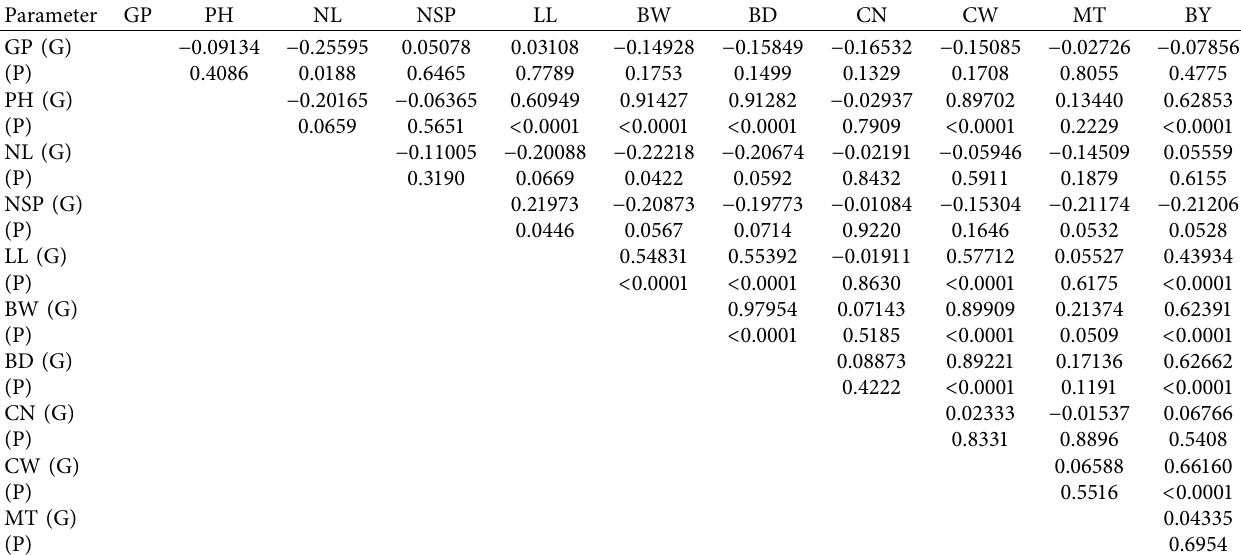
Table 5: Genotypic and phenotypic correlation coefficients of bulb yield and related traits of garlic accessions in in Ezo-Otte in the Chencha district of the Gamo highlands in southern Ethiopia in main cropping season, 2017.